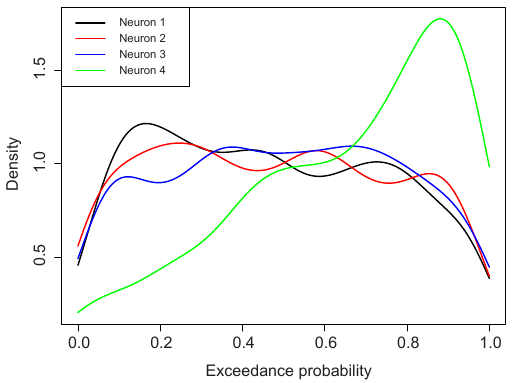
Figure 10. Density of exceedance probabilities in each neuron class.